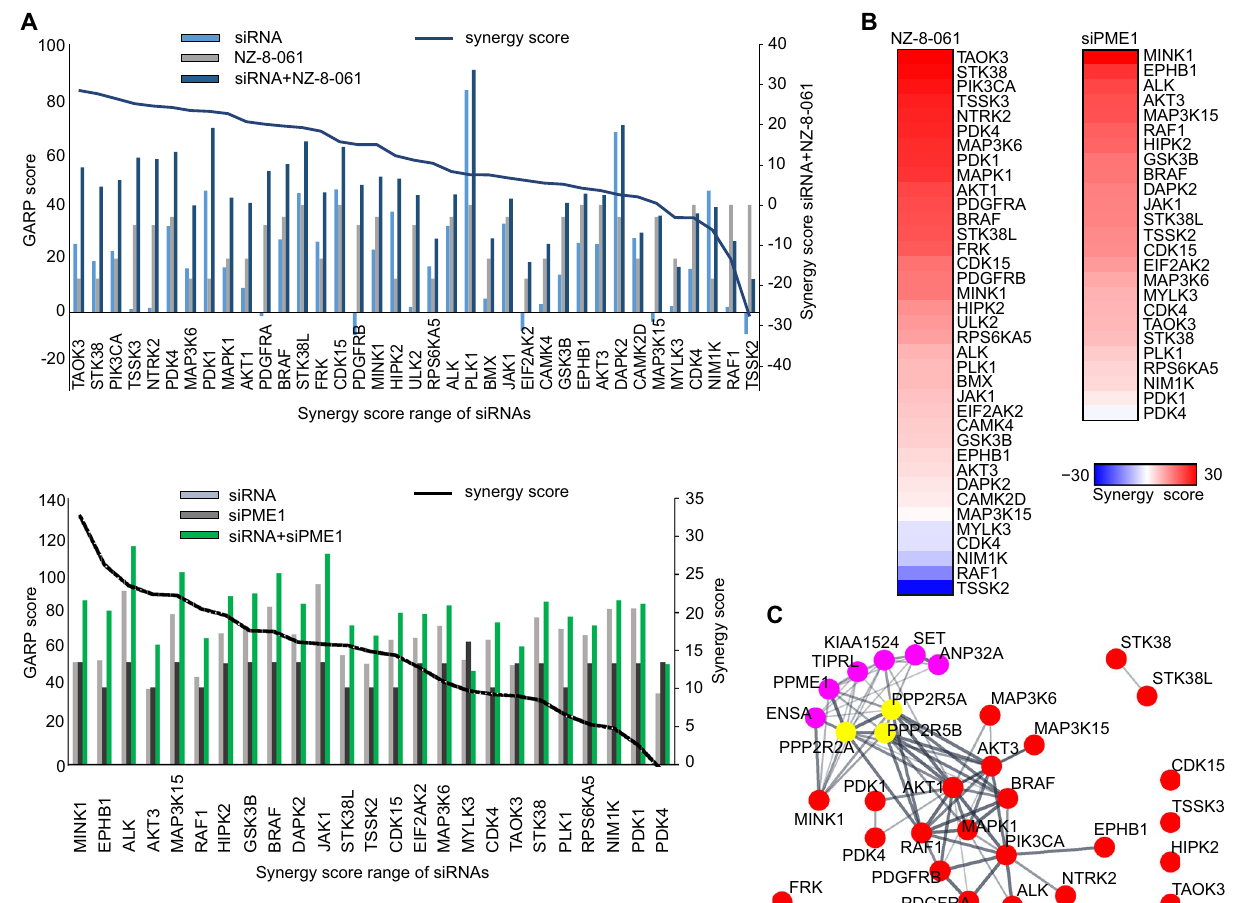
Figure 3. siRNA screening to kinases involved in GB cell synthetic lethality in combination with PP2A reactivation. ( A ) GARP scores of siRNA screen in T98G cells under NZ-8-061-treatment or PME-1 depletion (left axis). Kinases were ordered according to synergy scores of a siRNA (right axis). ( B ) Heat map representation of kinases involved in synthetic lethality in NZ-8-061-treated and PME-1-depleted T98G cells. Color bar indicates the synergy scores. ( C ) STRING interactive mapping of screen kinase hits onto PP2A